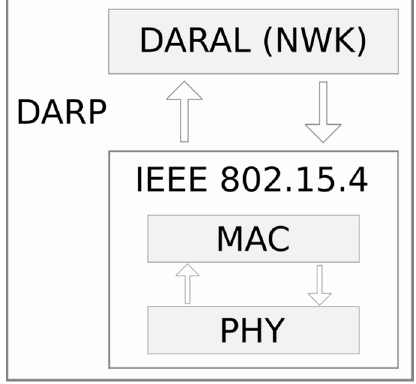
Figure 1. DARP Layer Structure.